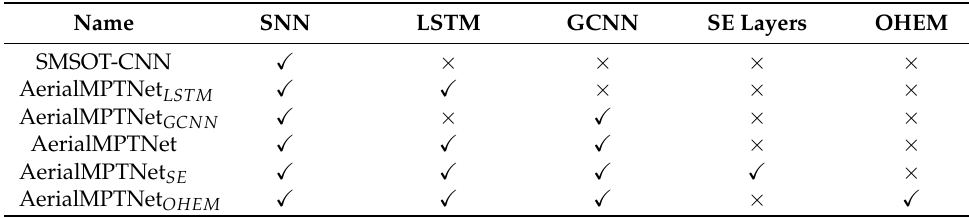
Table 9. Different network